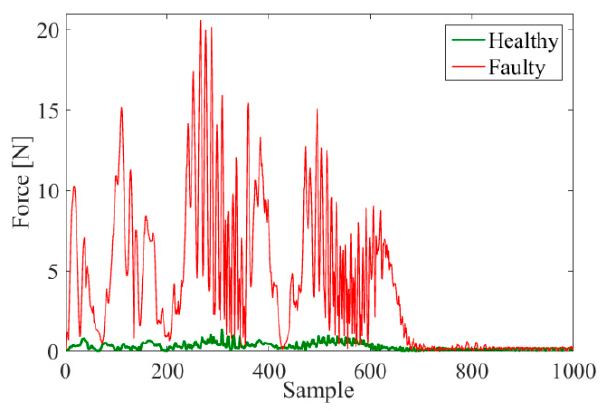
Figure 11. Magnetic force in starting torque in the healthy and faulty motor.